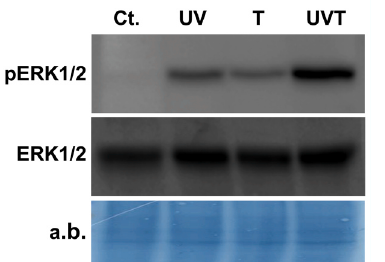
Figure 3. Induction of Spi-ERK phosphorylation by thermal and UV stresses. Immunoblot performed with ERK and pERK antibodies on protein extracts from coral nubbins incubated for 30 minutes in control (Cont.), thermal stress (T), UV stress (UV) or a combination of thermal and UV stresses (UV + T) conditions. The amido black total protein staining of the western blot membrane is shown as a loading control.